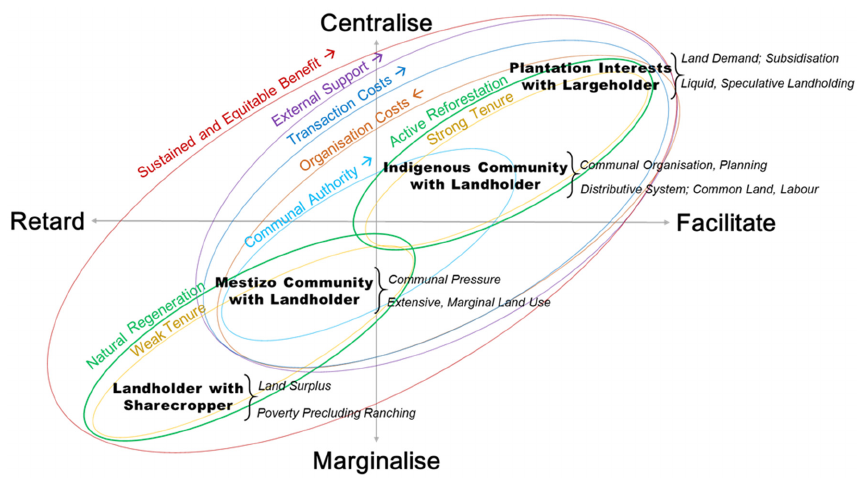
Figure 3. Key factors of forest-cover gain uniting sets of interacting agents. Arrows signify positive or negative effects of a factor on the facility and geographic centrality of forest-cover gain. Notes: the facility of forest-cover gain denotes the ease and efficiency by which interactions facilitate forest-cover gain, not the absolute area of forest-cover gain per se. Ellipses: these define key factors or traits of forest-cover gain uniting sets of interactions. Arrows pointing to the upper-right and lower-left, respectively, indicate a positive and negative effect of a factor on the facility and geographic centrality of forest-cover gain, e.g., greater external support and lower organisation costs both facilitate and centralise forest-cover gain. This schema is illustrative only, as clearly the effect of factors such as transaction costs will not maintain indefinitely at ever-higher values. Parentheses: labels indicate key, complementary traits of the primary (upper) and secondary (lower) agents of a given interaction promoting forest-cover